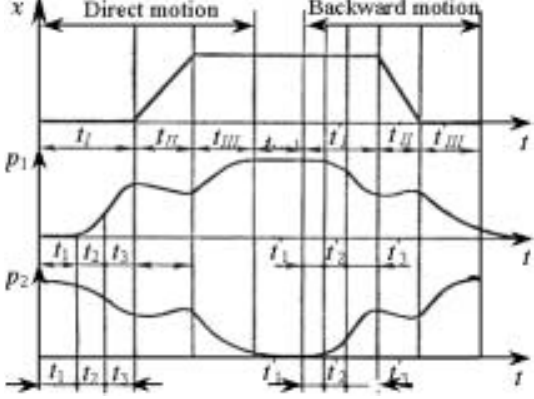
Fig. 4. Cyclogram of the pneumatic